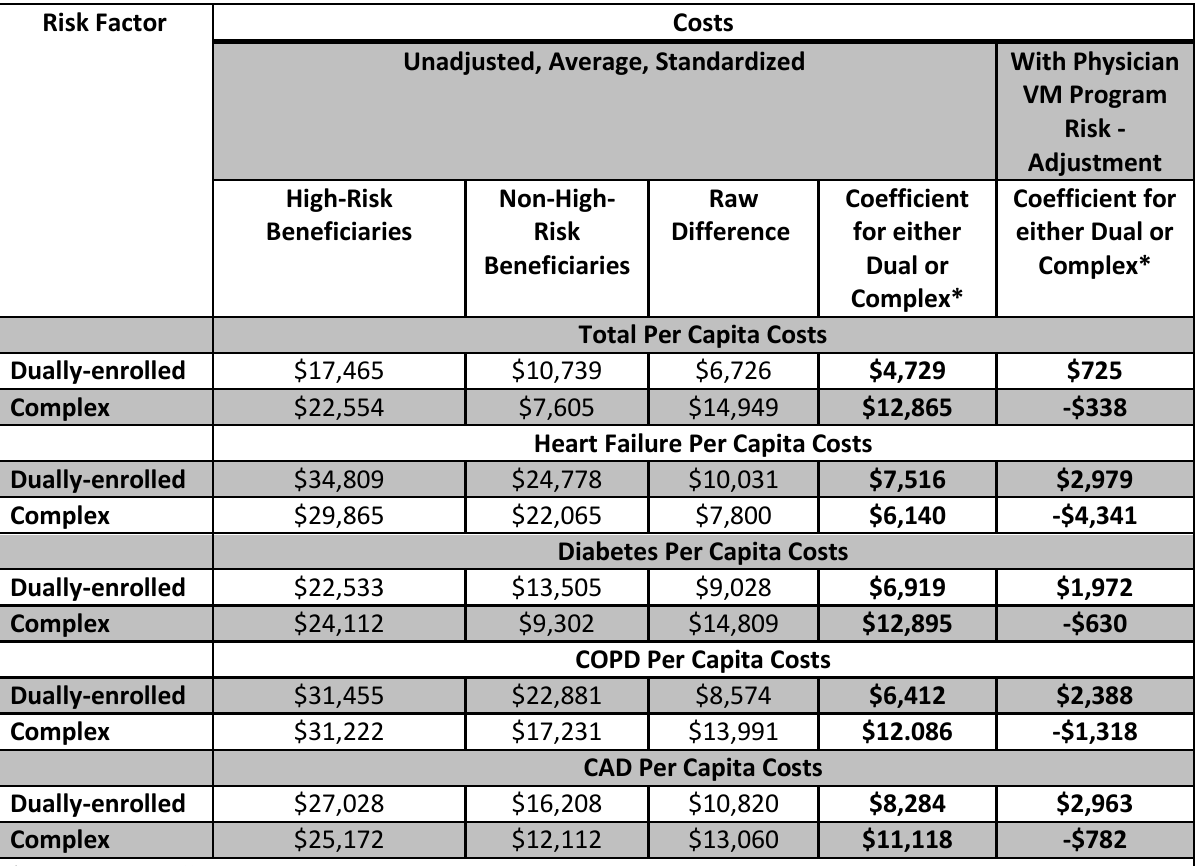
Table 10.7. Total and Condition-Specific Costs of Care for Dually-Enrolled or Complex